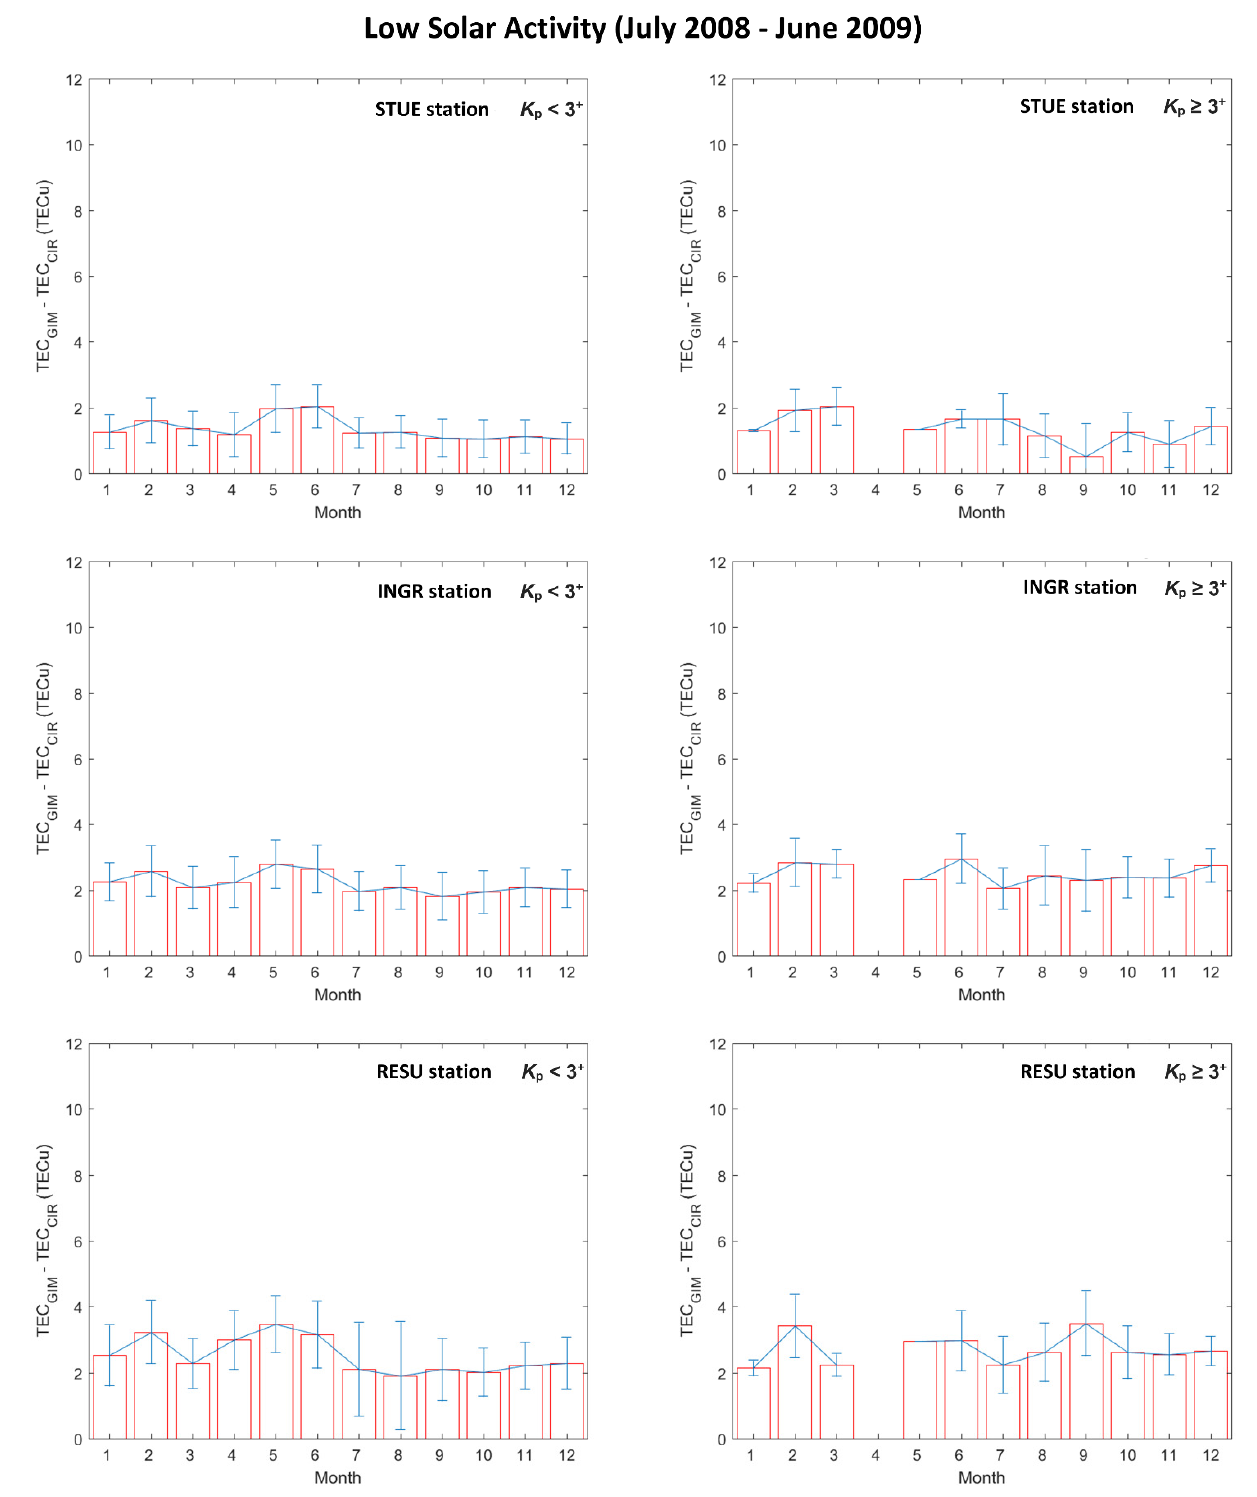
Figure 6. Mean monthly variation of the difference (TEC GIM -TEC CIR ), and corresponding standard deviation, for STUE (upper row), INGR (middle row) and RESU (lower row) for the LSA period between July 2008 and June 2009. Left panels refer to quiet geomagnetic values ( K p < 3 + ), while right panels refer to disturbed geomagnetic values ( K p ≥ 3 + ).